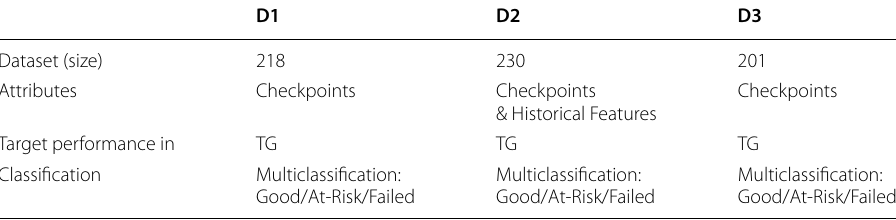
Table 1 Summary of the datasets